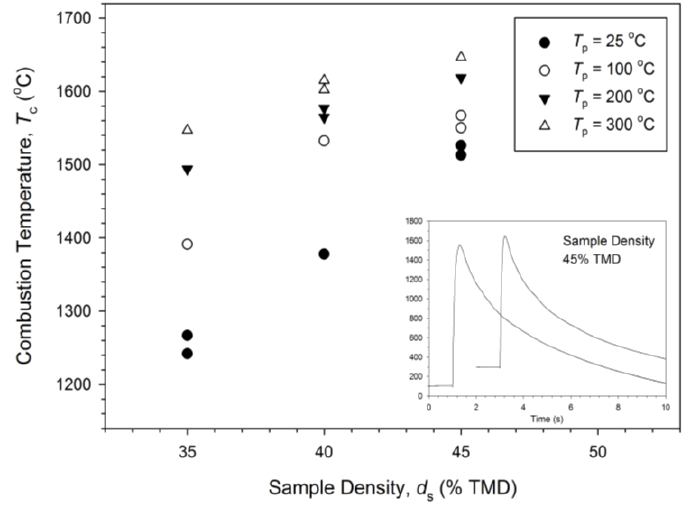
Figure 3. Effects of sample density and preheating temperature on combustion temperature of elemental powder compacts of Ta:Si =